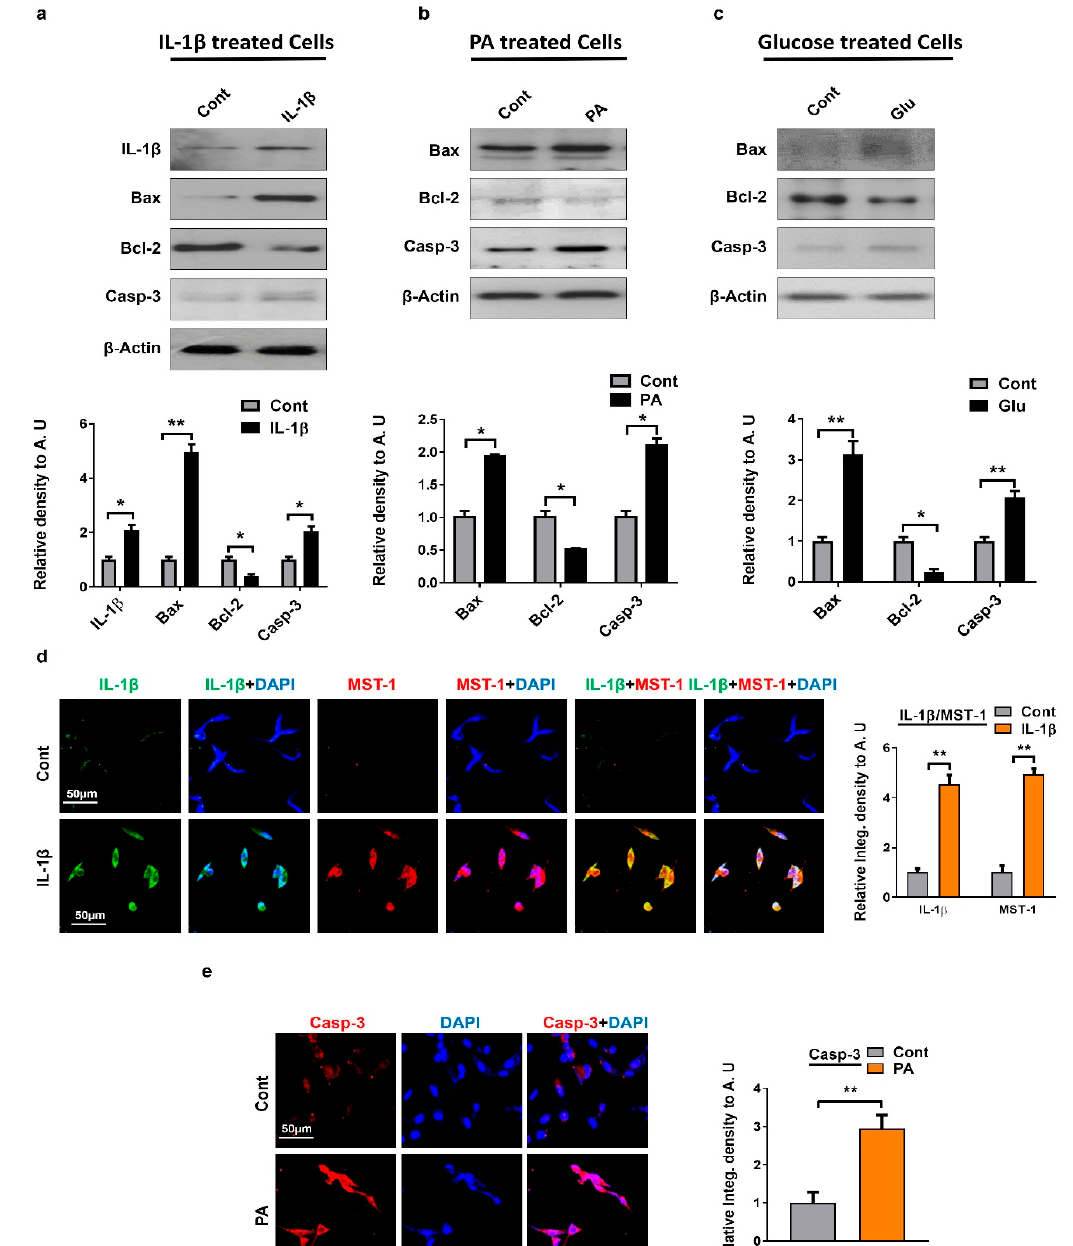
Figure 3. Metabolic deregulation induced apoptotic cell death in in vitro models: ( a – c ) Shown are the Western blot results of apoptotic markers Bax Bcl-2 can Cleaved-Casp-3 in IL-1 β , palmitic acid, and glucose treated cells HT22 cells. β -actin was used as a loading control. For protein band quantification ImageJ software was used. One-way ANOVA followed by post-hoc analysis was used for statistical analysis. The density values were expressed in arbitrary units (AUs) as the mean ± SEM; ( d ) given are the representative images of double immunofluorescence staining of IL-1 β and MST1 in IL-1 β treated HT22 cells; ( e ) confocal microscopic results of Caspase-3 expression in palmitic acid treated HT22 cells. The data are expressed as the mean ± SEM. * p < 0.05, ** p < 0.01.